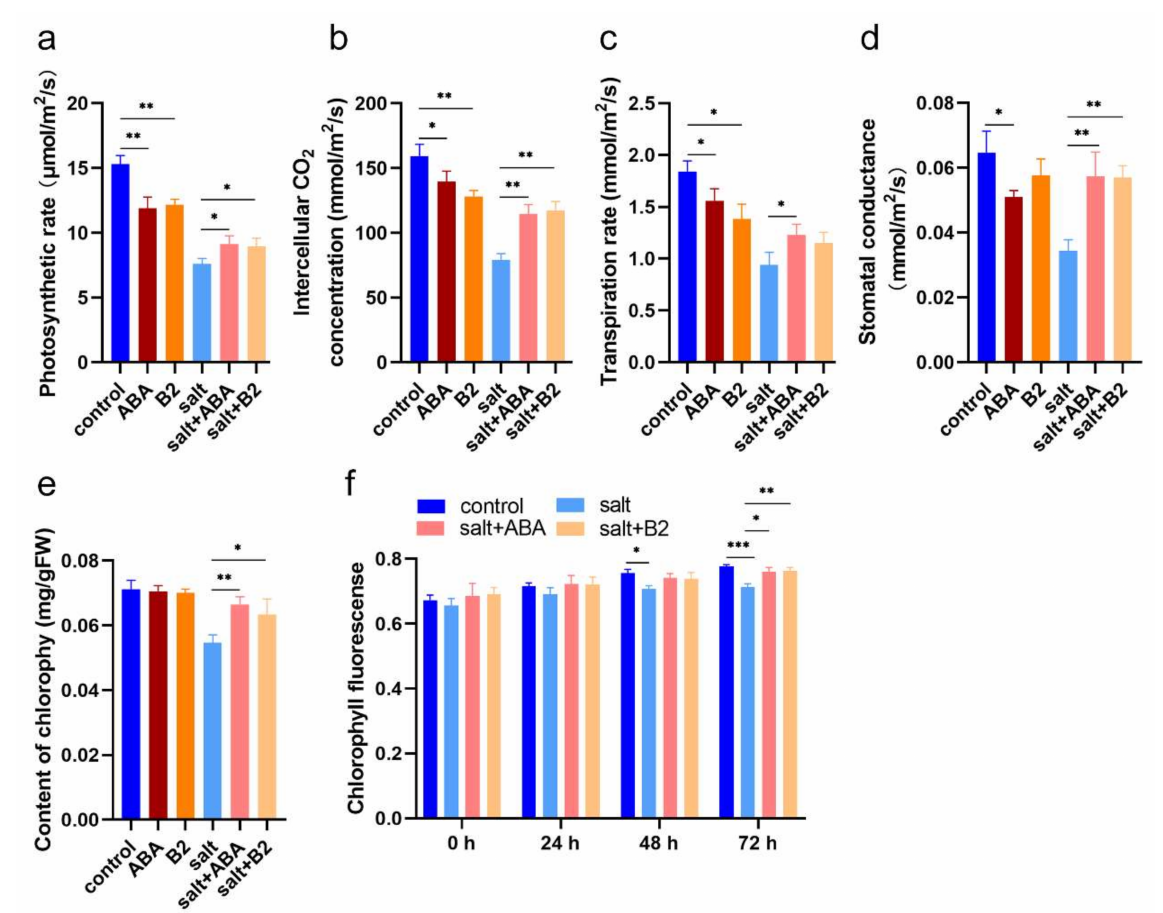
Figure 6. Photosynthesis and chlorophyll fluorescence of maize. ( a ) Photosynthetic rate of different treatments. ( b ) Intercel- lular CO 2 concentration of different treatments. ( c ) Transpiration rate of different treatments. ( d ) Stomatal conductance of different treatments. ( e ) The content of chlorophyll of different treatments. ( a – e ) The latest unfolding leaf measured after 6 days of salt treatment. ( f ) The chlorophyll fluorescence measured after 0, 24, 48, and 72 h of salt treatment. The concentration of B2 was 1.0 µ M, and ABA concentration was 100 µ M. Values were significantly different from controls by t -test at * p < 0.05, ** p ≤ 0.01, or *** p ≤ 0.001. Bars mean SD ( n =